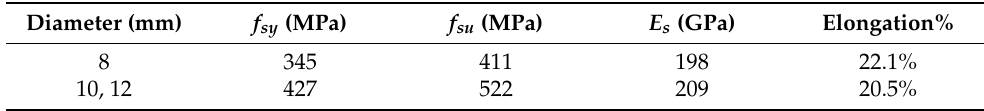
Table 1. Mechanical properties of the steel